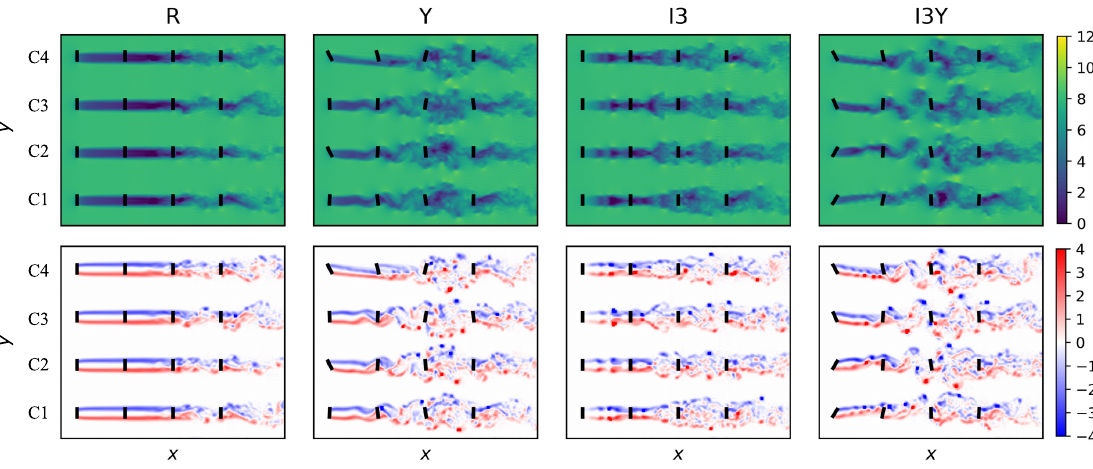
Figure 5. Instantaneous planviews at hub height for uniform inflow cases R, Y, I3, and I3Y at t = 300 s. Top: Streamwise velocity. Coloring in m s − 1 . Bottom: Wall-normal vorticity. Coloring in s − 1